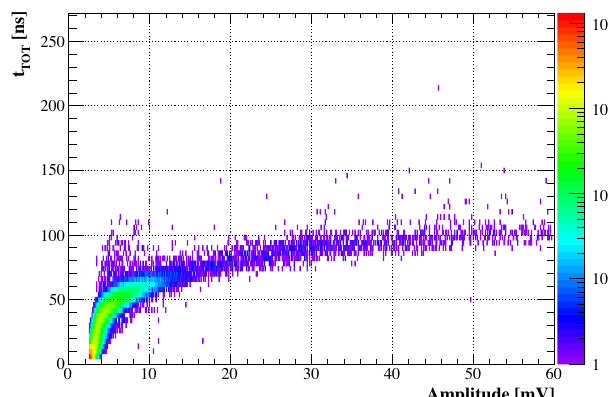
FIG. 16. Correlation between IE amplitude and t collected during the controlled loss